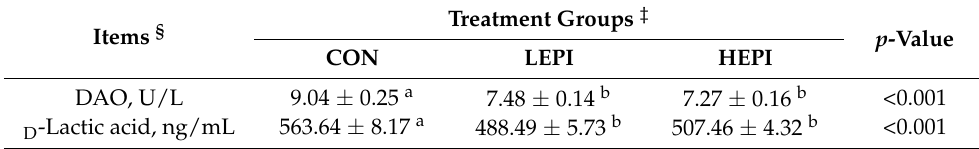
Table 1. Effects of epicatechin on the serum indices of mice †